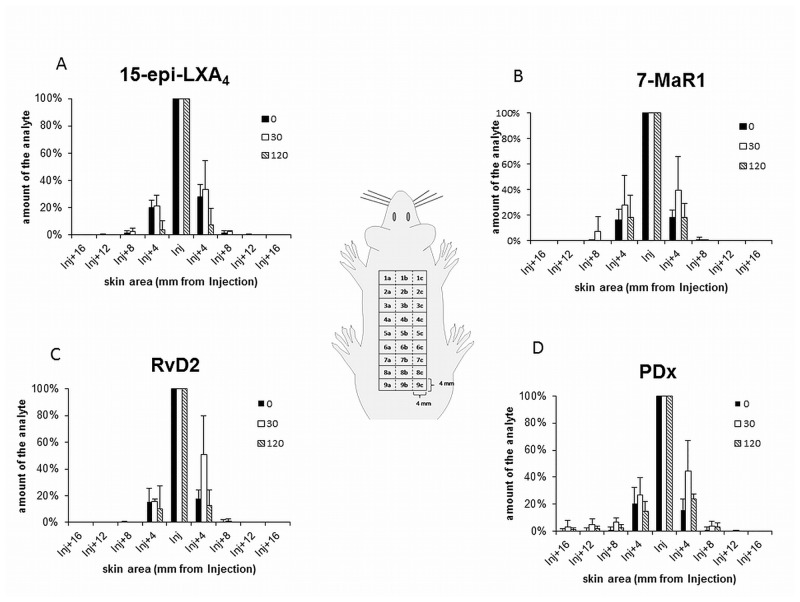
Distribution behavior of 15-epi-LXA4, RvD2, PDX and 7-MaR1.The distribution of the SPM was determined by direct analysis of skin areas, 30 min and 2 h after their subcutaneous injection. The results for 15-epi-LXA4 (A), 7-MaR1 (B), RvD2 (C) and PDX (D) are shown as examples.